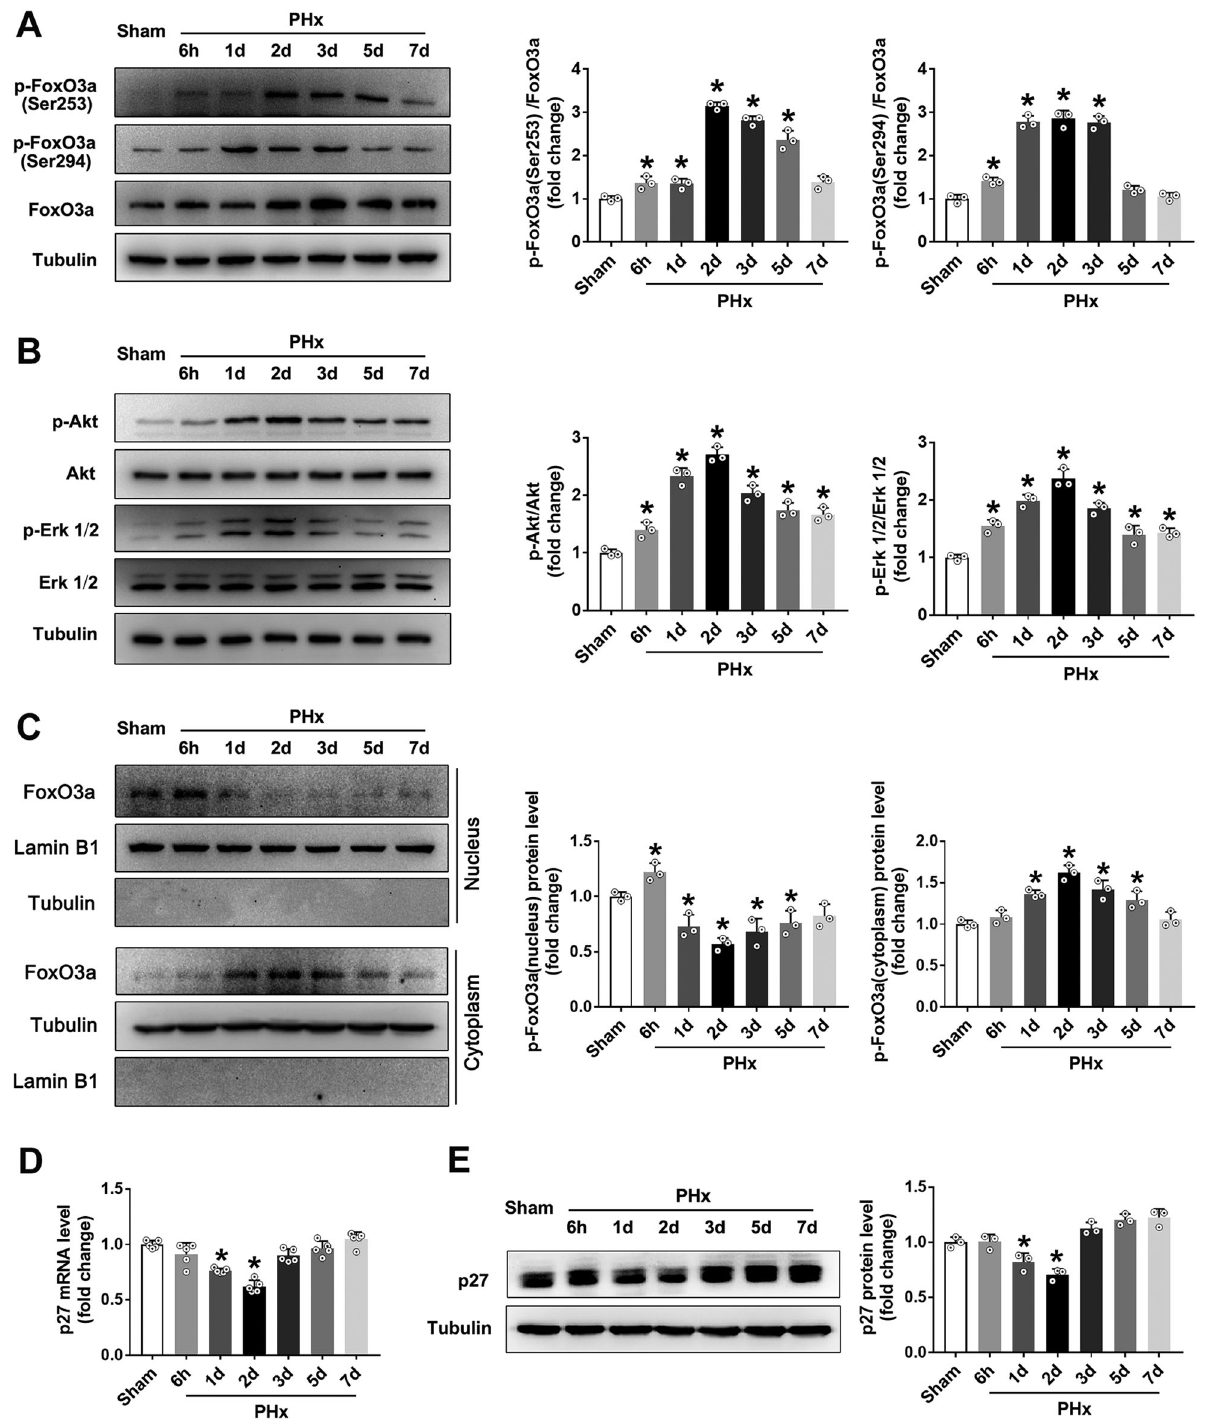
Fig. 4 The changes of FoxO3a signaling pathway at different time points after PHx in mice. After the C57 mice were subjected to PHx, the FoxO3a signaling pathway in the liver was determined at different time points (6 h, 1 d, 2 d, 3 d, 5 d, and 7 d). A Western blot analysis and quanti fi cation of FoxO3a and its phosphorylation forms (Ser253 and Ser294). B Western blot analysis and quanti fi cation of Akt and Erk with their phosphorylation forms. C Western blot analysis and quanti fi cation of FoxO3a protein levels in nucleus and cytoplasm. D Q-PCR determination of p27 expression, n = 5. E Western blot analysis and quanti fi cation of p27 protein level. Data are shown as means ± SEM of three independent experiments. * P < 0.05 vs Sham